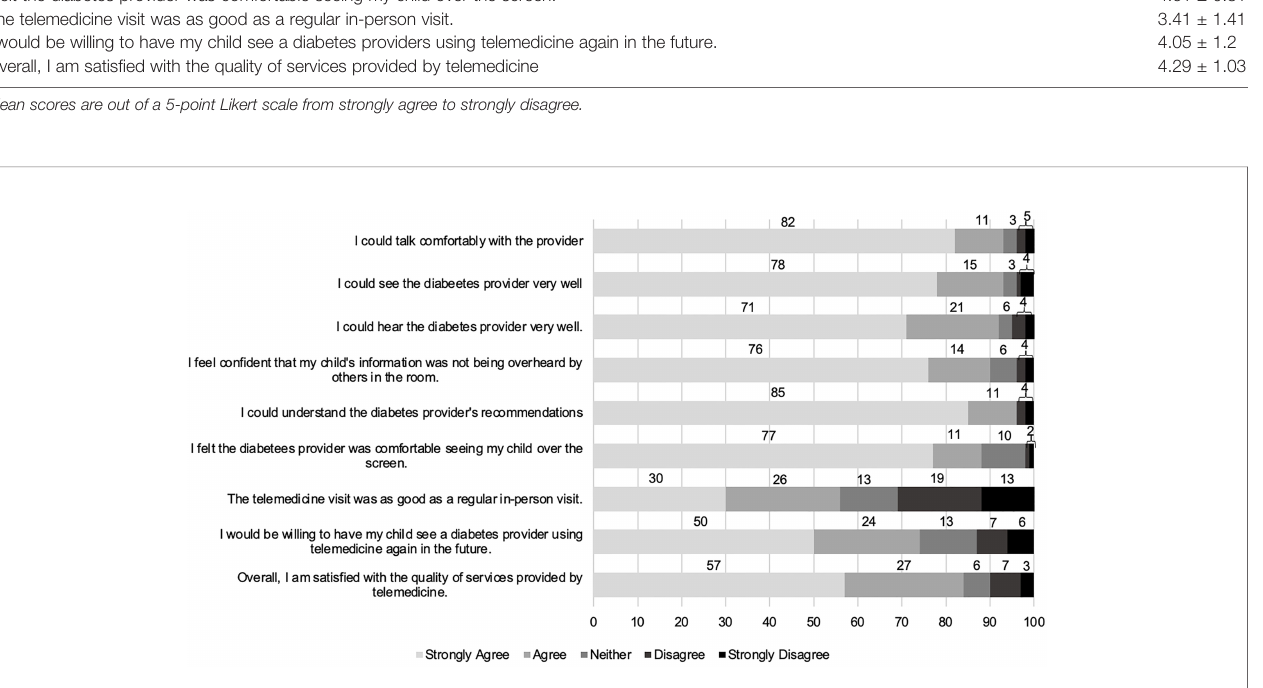
FIGURE 1 | Parent Satisfaction Survey with diabetes telemedicine services: Percent of parents reporting Likert scale responses.